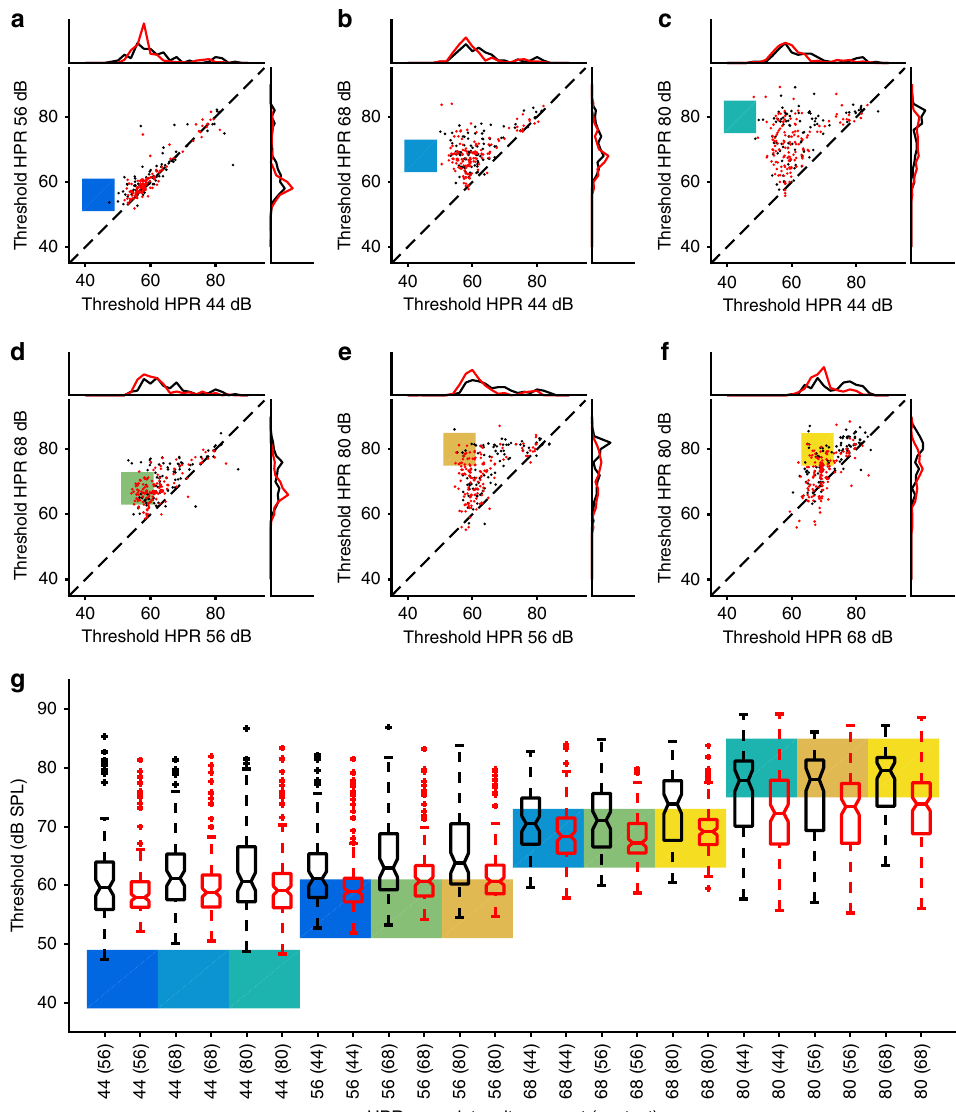
Fig. 3 Adaptive coding, meta-adaptation and the effects of HHL. a – f Adapted thresholds of all multi-unit clusters (red — exposed, black — control) for all six combinations of HPRs in the switching stimulus. Coloured patches indicate the intensity ranges of the HPRs. a Switch between 44 and 56 dB HPRs, b 44 vs. 68, c 44 vs. 80, d 56 vs. 68, e 56 vs. 80 and f 68 vs. 80. g Box plots of adapted thresholds of RLFs from control (black) and exposed animals (red) for HPRs centred on 44, 56, 68 and 80 dB SPL. On each box, the central mark indicates the median, with the notches specifying the interval of the median, and the bottom and top edges of the box indicate the 25th and 75th percentiles, respectively. The whiskers extend to the most extreme data points not considered outliers, and the outliers are plotted individually using the + symbol. The intensity ranges of the HPRs are indicated by the coloured patches. The context, that is, the other HPR of each switching stimulus, is given in the x -axis label, and the colour of the patch refers to the panel where the corresponding raw data are